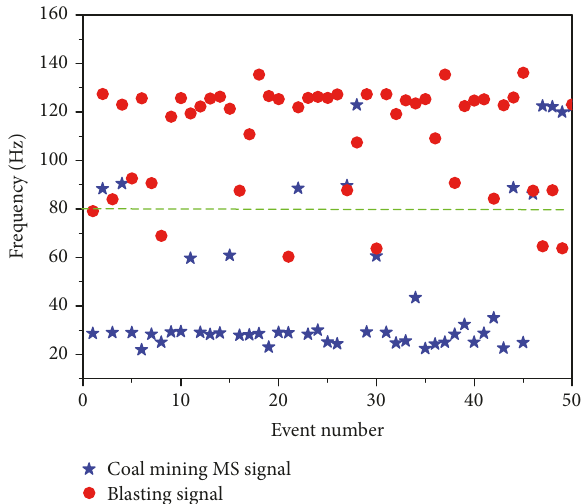
Figure 4: Duration distribution of coal mining MS and blasting signals recorded in the coal